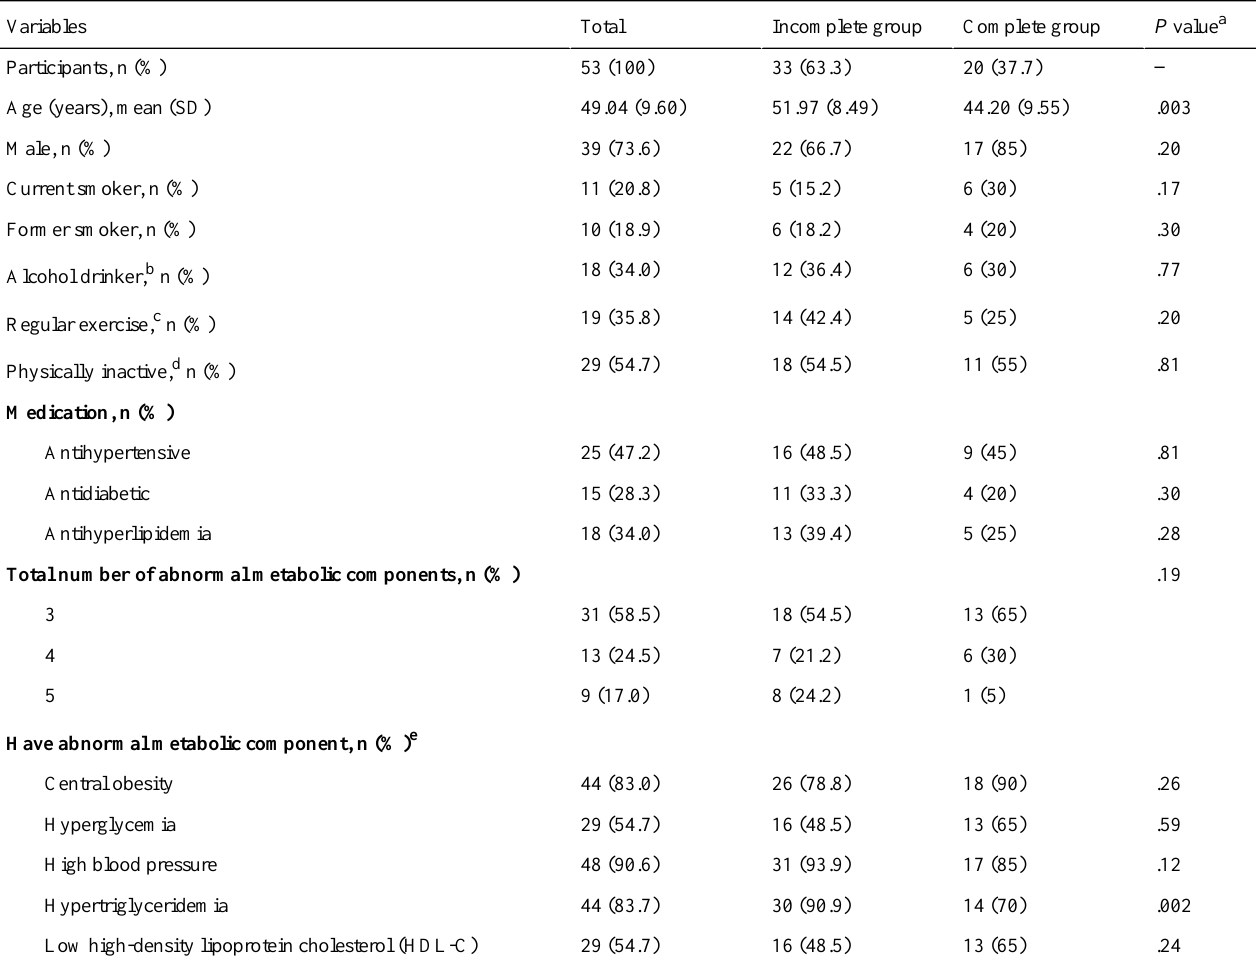
Table 1. Clinical characteristics of the study participants.